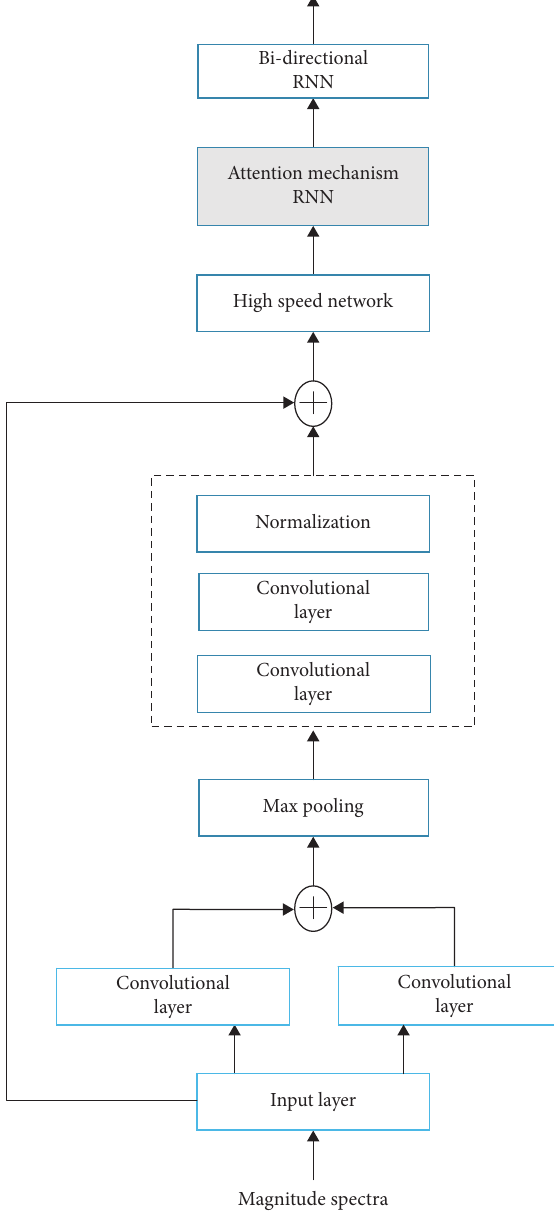
Figure 2: Network architecture of proposed